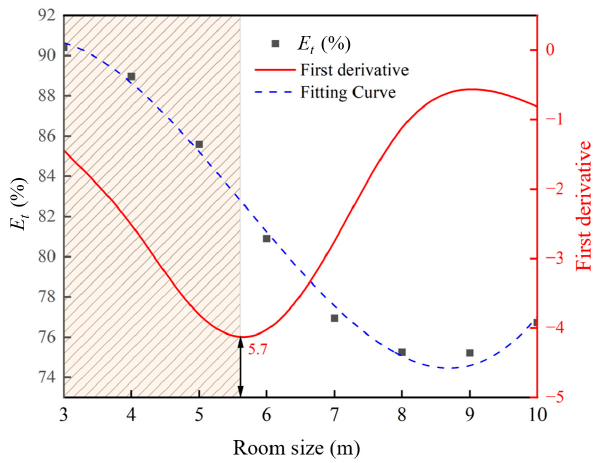
Figure 8. Change of ventilation efficiency with room